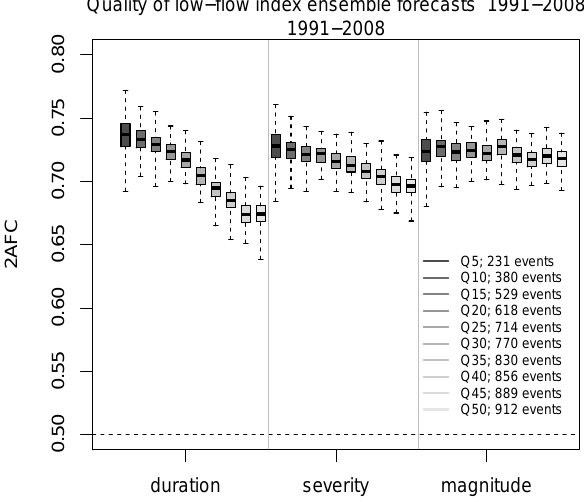
Fig. 6. Overall performance of duration, severity and magnitude ensemble forecasts, subject to the chosen streamflow drought de- tection threshold for the Thur catchment. The boxes indicate the range, inter-quartile range and median of the 2AFC score, found by resampling the forecast in the verification period 1000 times. The number of observed streamflow drought events for each threshold is given in the